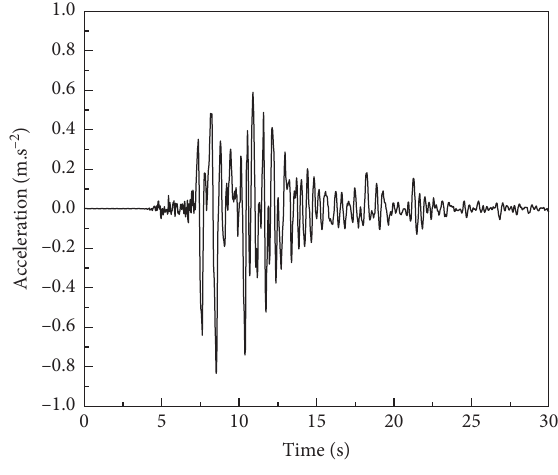
Figure 3: Seismic